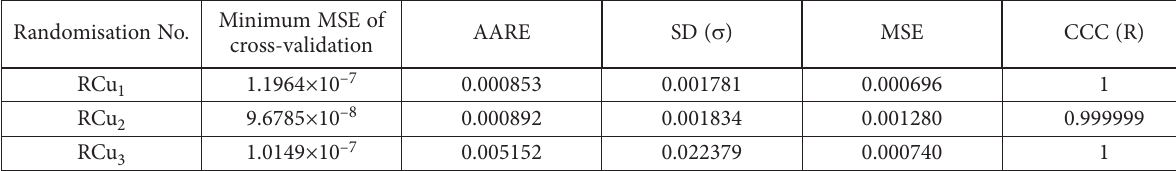
Figure 12. FTIR spectra of (a) coconut shell and (b) Cu(II) loaded coconut Table 8. Performance of the optimized GA network